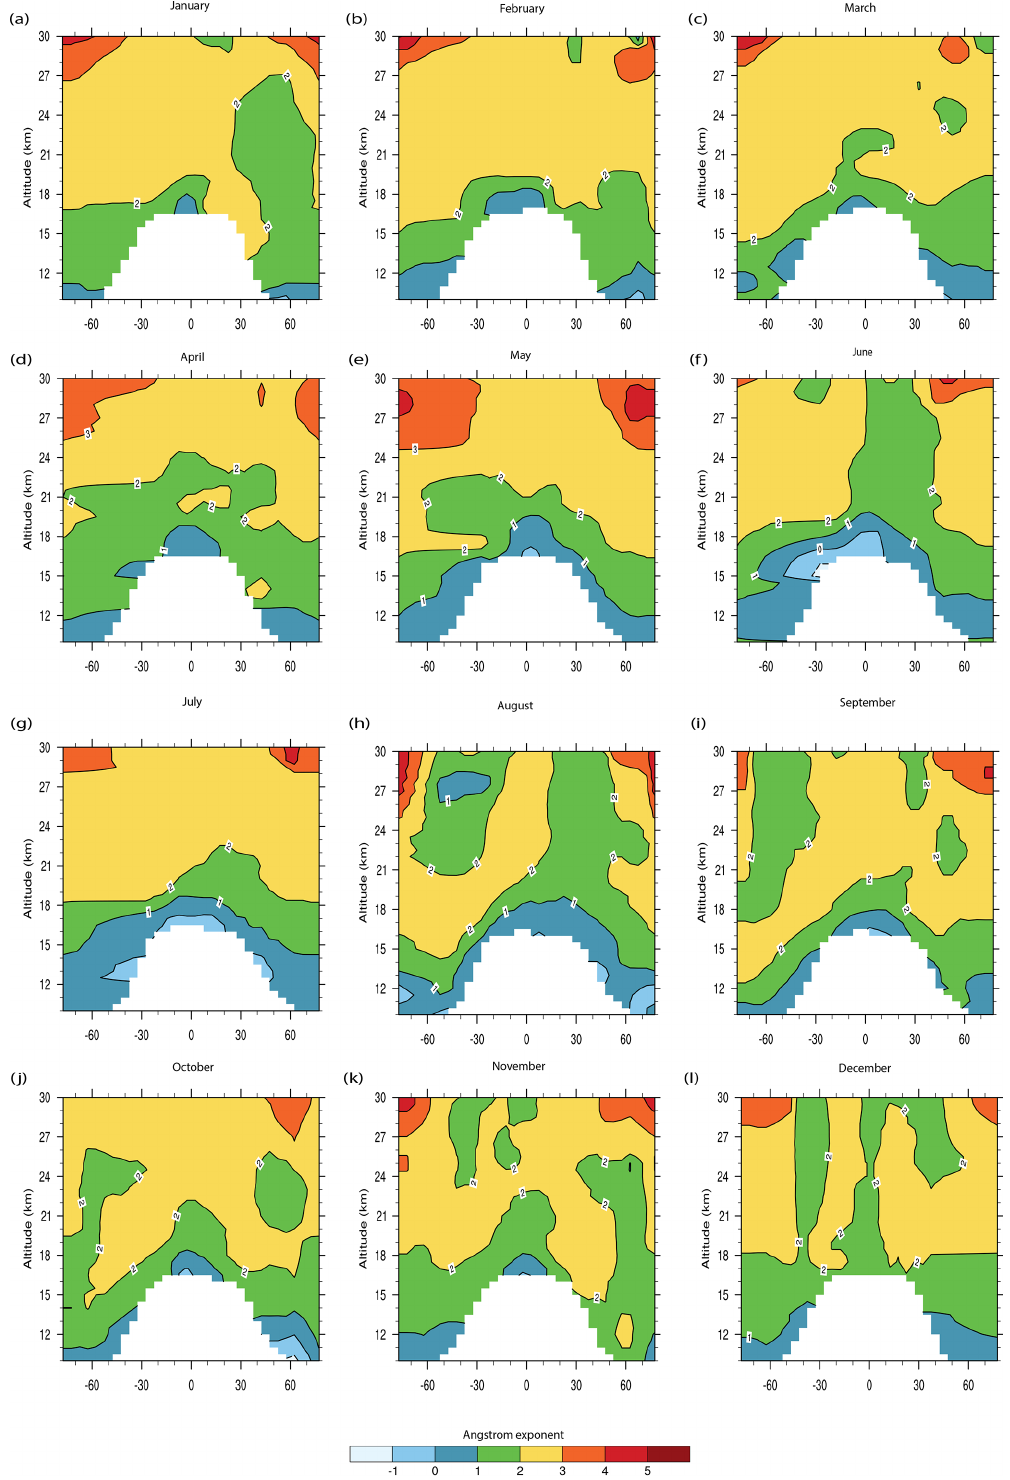
Figure 6. Altitude versus latitude of pseudo Ångström exponent monthly climatology derived using OSIRIS 750nm extinction and SAGE II and SAGE III/ISS 525nm extinction. A 3 × 3 median smoothing is used to remove any outliers and then linearly interpolated to fill in any missing